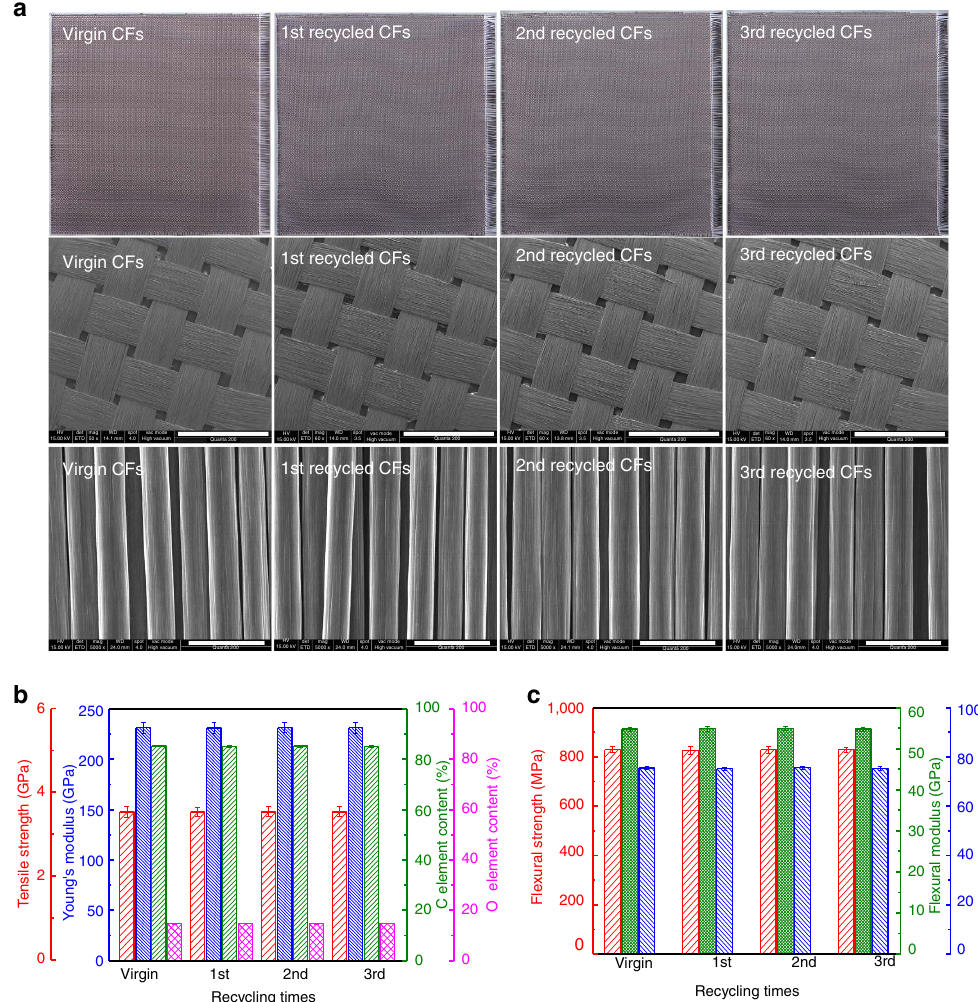
Figure 5 | Multiple recycling and regeneration of the cross-ply CF/PHTcomposite laminates. ( a ) The photos and SEM images of virgin and recycled CFs (the scale bars for second and third row SEM images are 2mm and 20 m m, respectively); ( b ) The monofilament tensile properties and surface element contents of virgin and recycled CFs; ( c ) The flexural properties and short-beam strengths of original and regenerated cross-ply CF/PHT composite